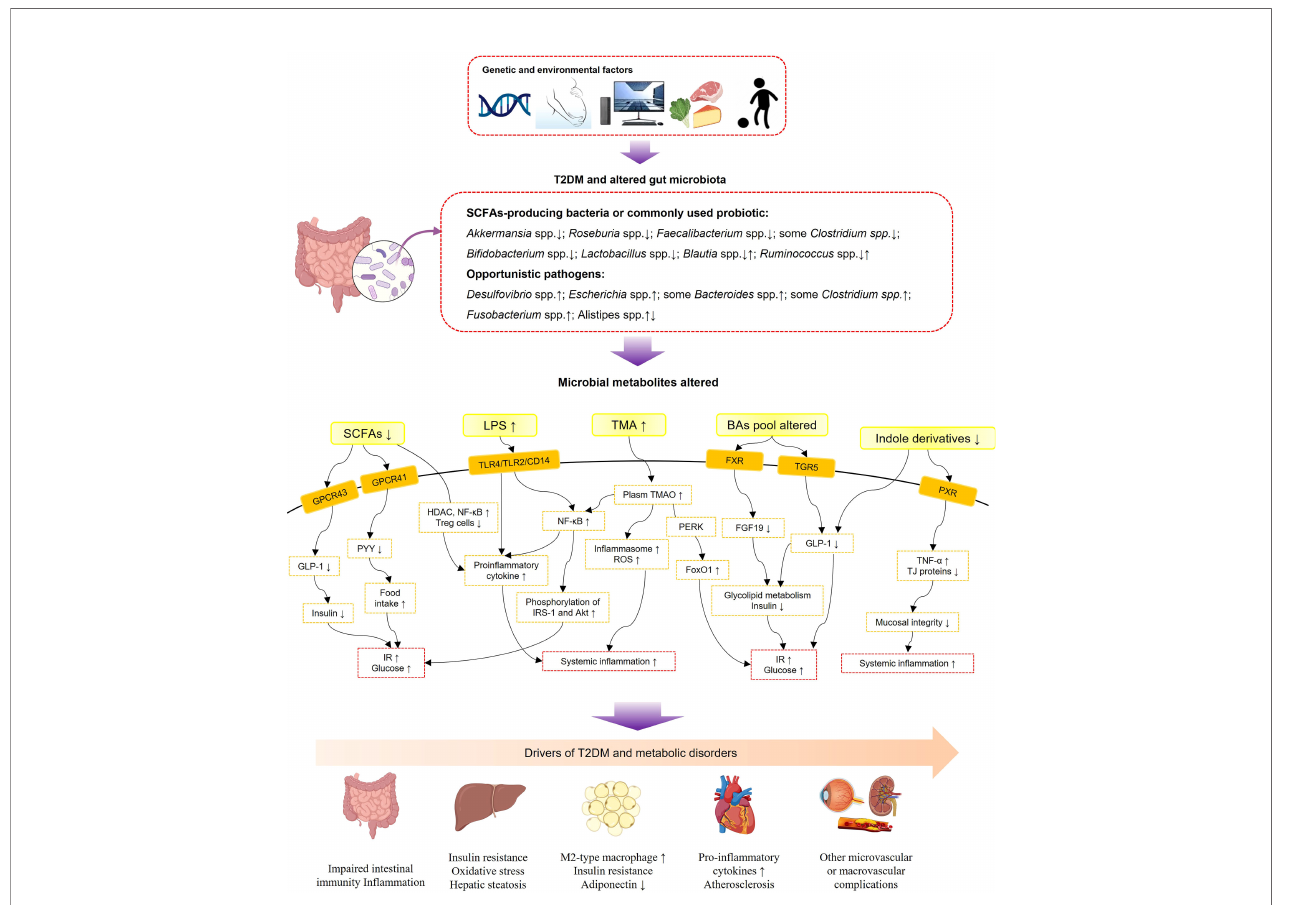
FIGURE 1 | Schematic view of gut microbiota, microbial metabolites, and T2DM-associated metabolic disorders. SCFAs, short-chain fatty acids; LPS, lipopolysaccharides; TMA, trimethylamine; TMAO, trimethylamine-N-oxide; BAs, bile acids; GPCR43, G-protein-coupled receptor 43; GPCR41, G-protein-coupled receptor 41; TLR4, toll-like receptor 4; TLR2, toll-like receptor 4; CD14, cluster of differentiation 14; FXR, farnesoid X receptor; TGR5, Takeda G protein-coupled receptor 5; PXR, pregnane X receptor; GLP-1, glucagon-likepeptide-1; PYY, peptide tyrosine-tyrosine; HDAC, histone deacetylases; NF- k B, nuclear factor-kappaB; IRS-1, insulin receptor substrate-1; ROS, reactive oxygen species; PERK, protein kinase-like ER kinase; FoxO1, forkhead box-O1; FGF19, fi broblast growth factor 19; TNF- a , tumor necrosis factor alpha; TJ proteins, tight-junction proteins; IR, insulin